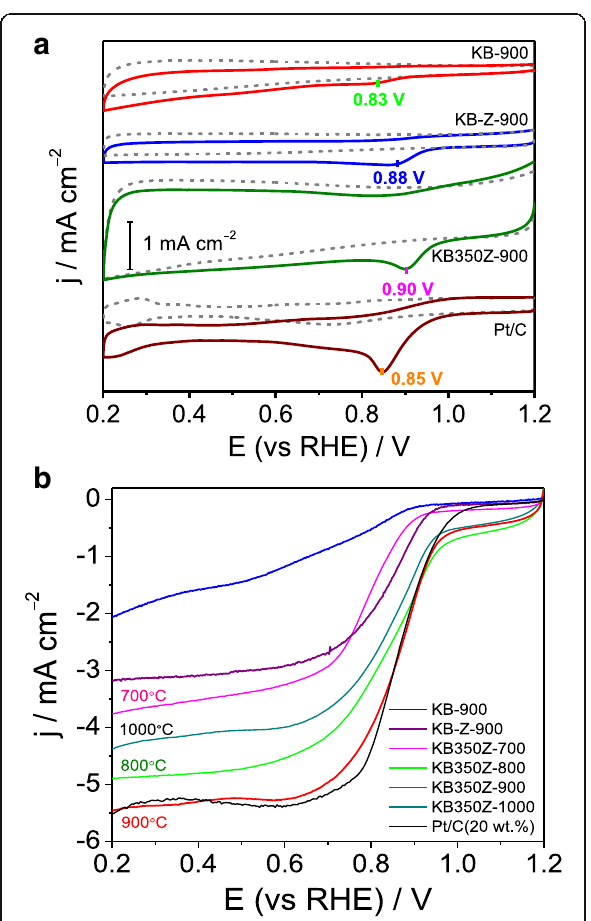
Fig. 3 a CV curves of KB900, KB-Z-900 and KB350Z-900 in N 2 versus O 2 saturated KOH solution; b LSV curves of the prepared catalysts and JM Pt/C